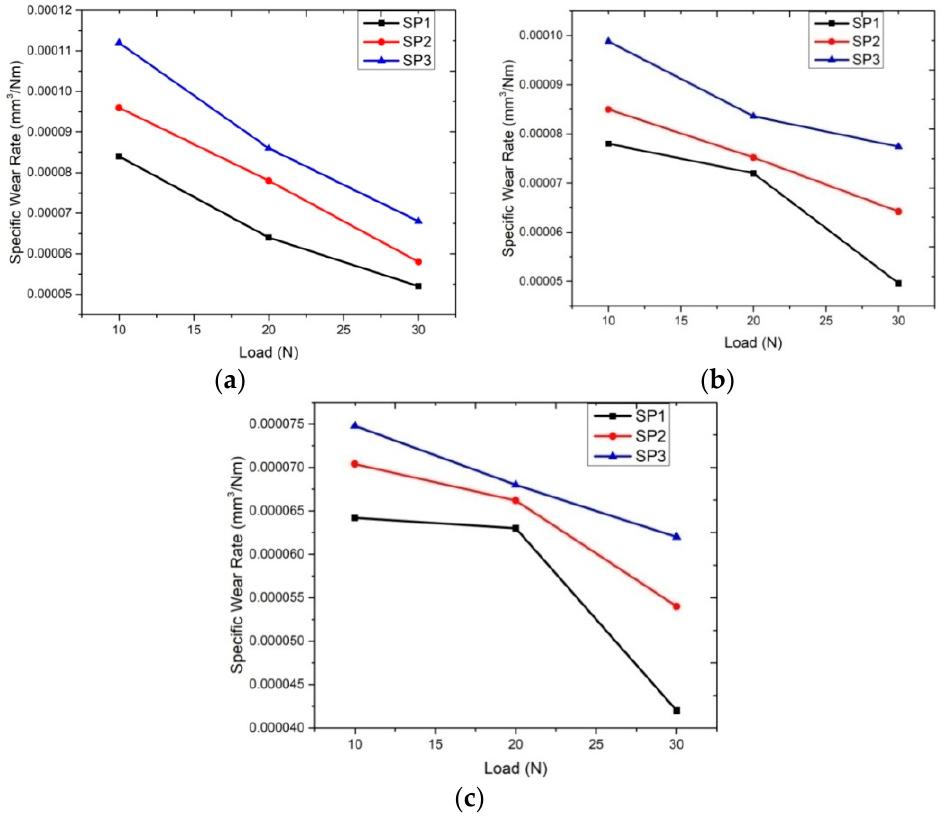
Figure 6. Influence of load on SWR at a speed of ( a ) 500 rpm, ( b ) 600 rpm and ( c ) 700